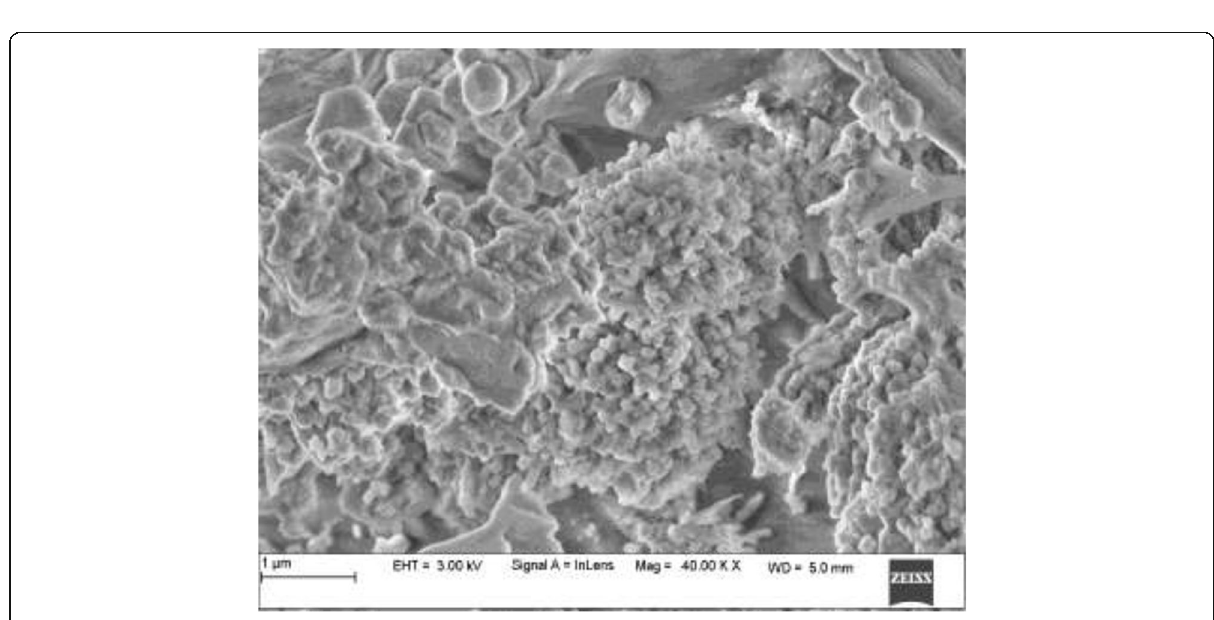
Fig. 3 SEM images of chitin from